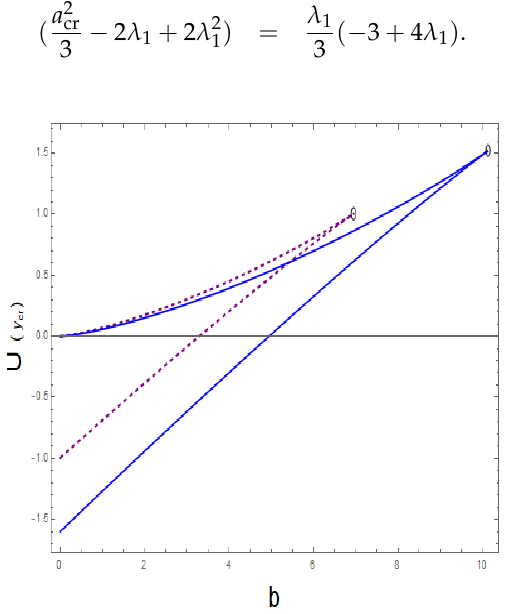
Figure 9. Shown are two sets for n = 4 ( a = 0 and a = 0.5 m 0 , respectively), of the position of the extrema as a function of b n . For each a , the upper curve corresponds to a maximum and the lower one to the position of the minimum. The two curves meet at a certain b n = b value, which increases with decreasing a . The dashed line corresponds to a = 0.5 m 0 , while the continuous line is for a = 0. Equation (25) was used and the corresponding MATHEMATICA routine can be retrieved from